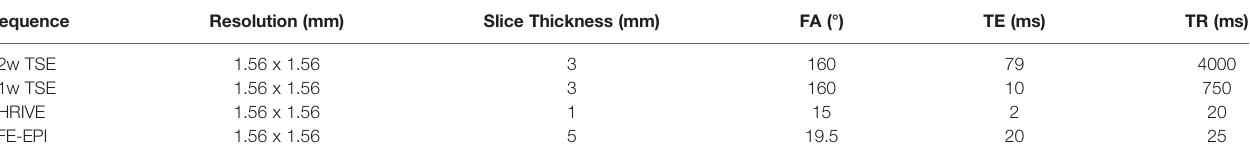
TABLE 2 | Scan parameters for each MR